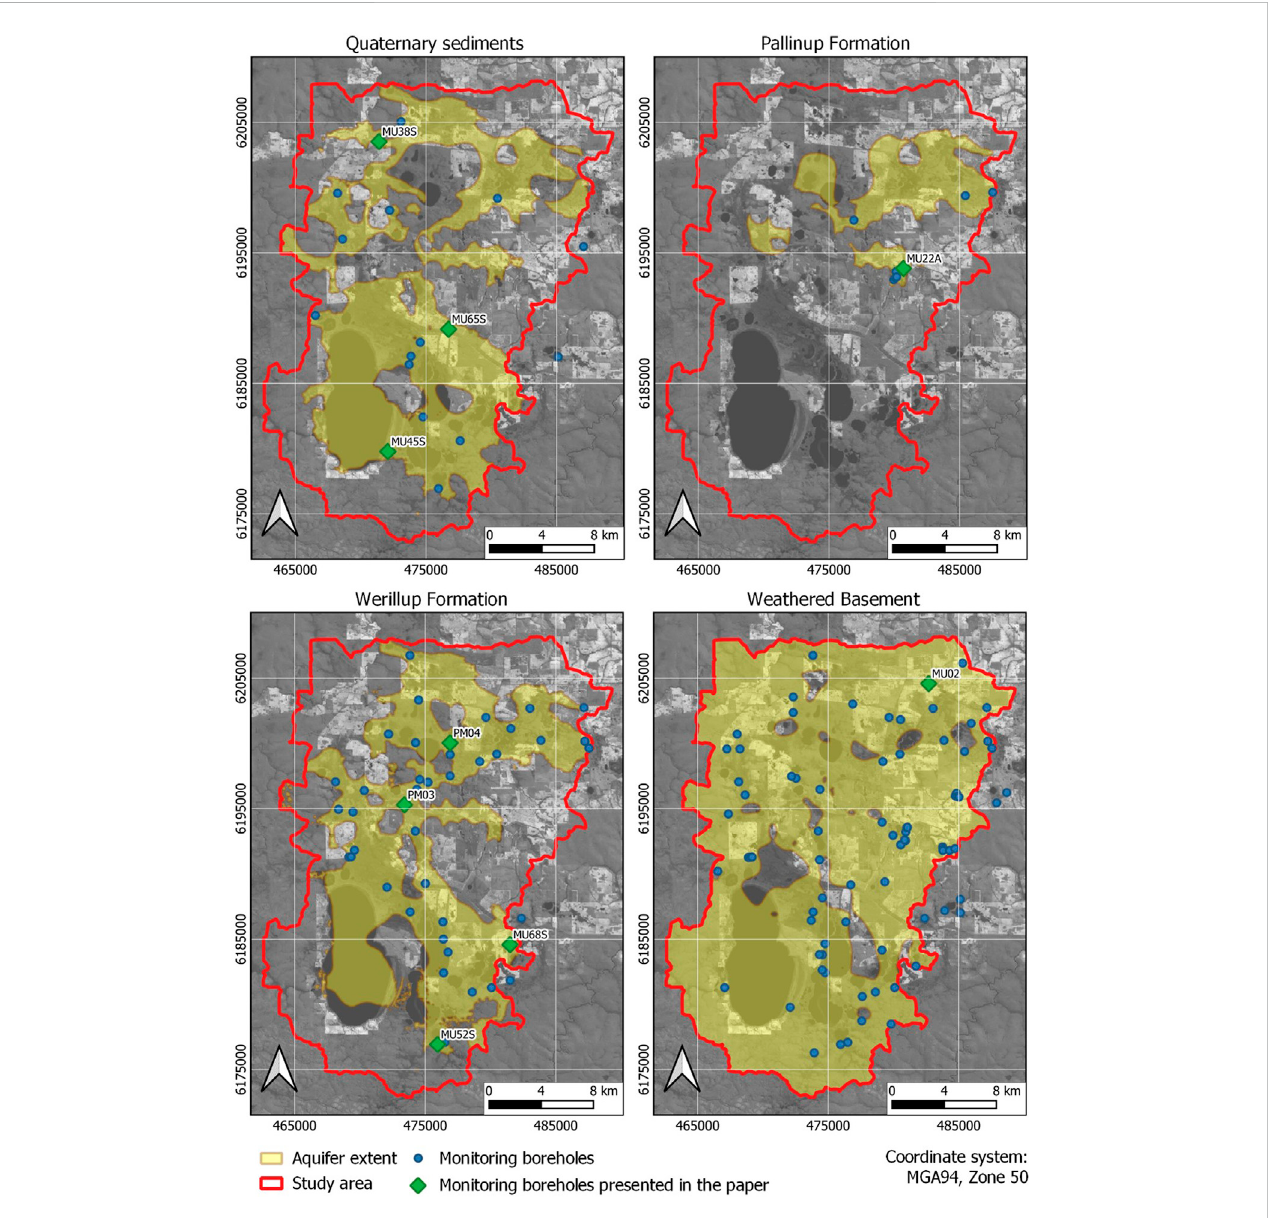
FIGURE 6 Location of groundwater monitoring boreholes screened in the different hydrogeological